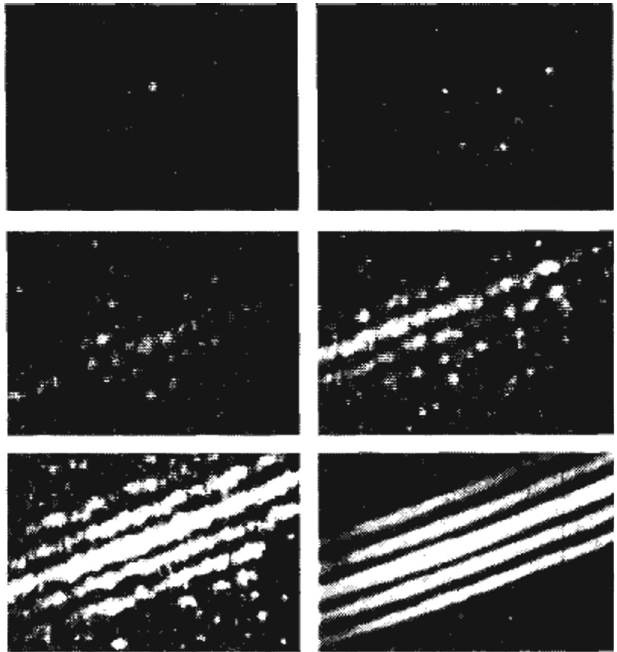
FIG. 9. The Merli-Missiroli-Pozzi experiment 1974 – 76, repro- duced from Ref. [49] with the permission of the American Association of Physics